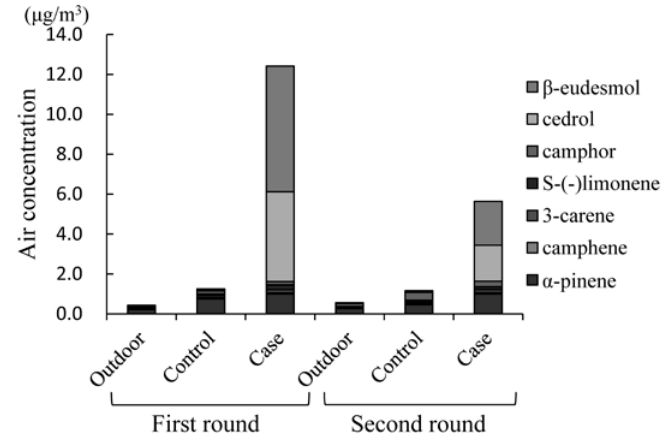
Figure 4. Air concentrations of terpenes.